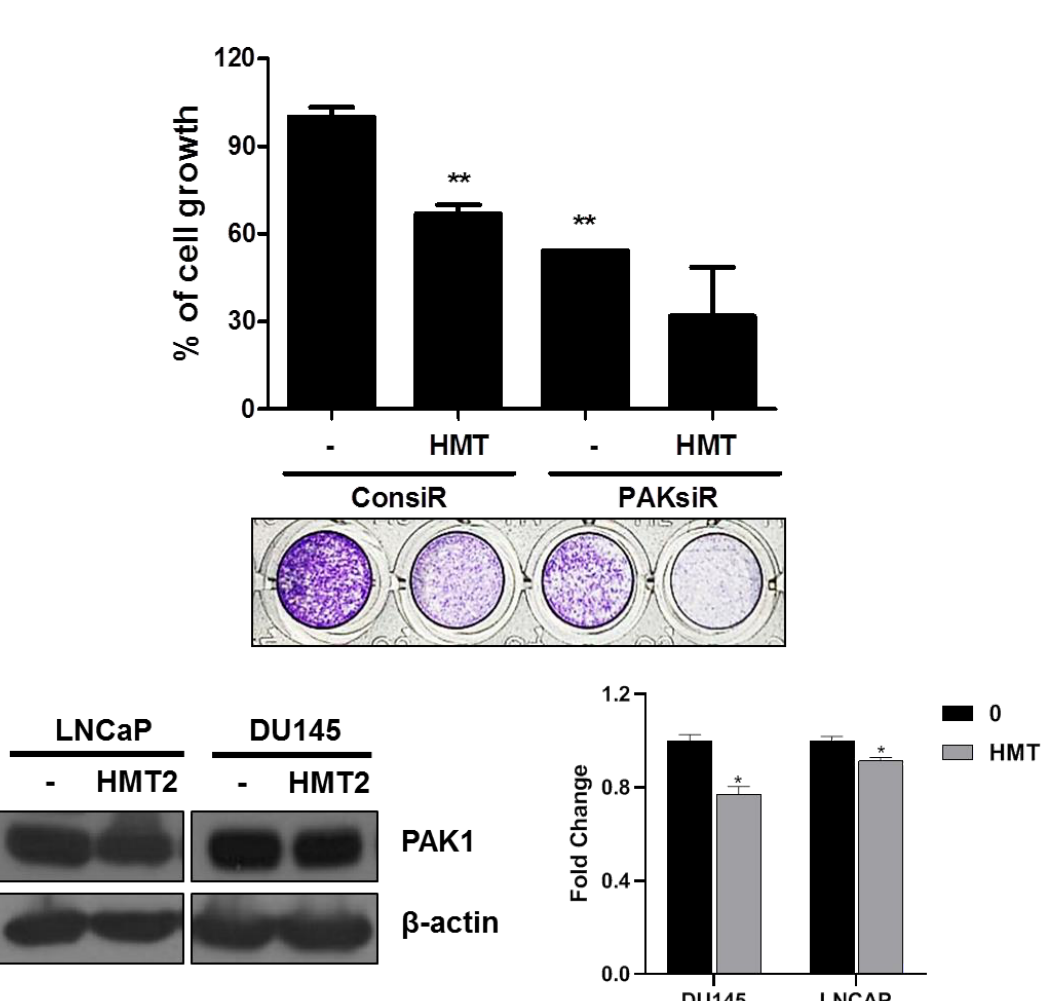
Figure 4. Effect of PAK-1 siRNA on cell migration, proliferation, and apoptosis-related markers in HMT treated PC-3 cells. PC-3 cell lysates treated with PAK-1 siRNA and HMT were prepared and subjected to Western blotting ( A ) with antibodies against PAK-1, AKT, LIMK1/2, cofilin, cyclin D1, c-cas3, and β-actin. The bar graph indicates the ratio of the protein of interest to β-actin by densitometric analysis presented as fold changes of the control. Data represent mean ± SD. * p < 0.05, ** p < 0.01, and *** p < 0.001 compared with control. ( B ) The cell growth was assayed by crystal violet staining. The stained cells were photographed and resolved in 70% EtOH, and the absorbance was measured using a microplate reader. Data represent mean ± SD. * p < 0.05, ** p < 0.01, and *** p < 0.001 compared with control. ( C ) HMT-treated PAK-1 expression in LNCaP and DU145 cells by Western blotting. The bar graph indicates the ratio of the protein of interest to β-actin by densitometric analysis presented as fold changes of the control. Data represent mean ± SD. * p < 0.05 compared with con- trol.